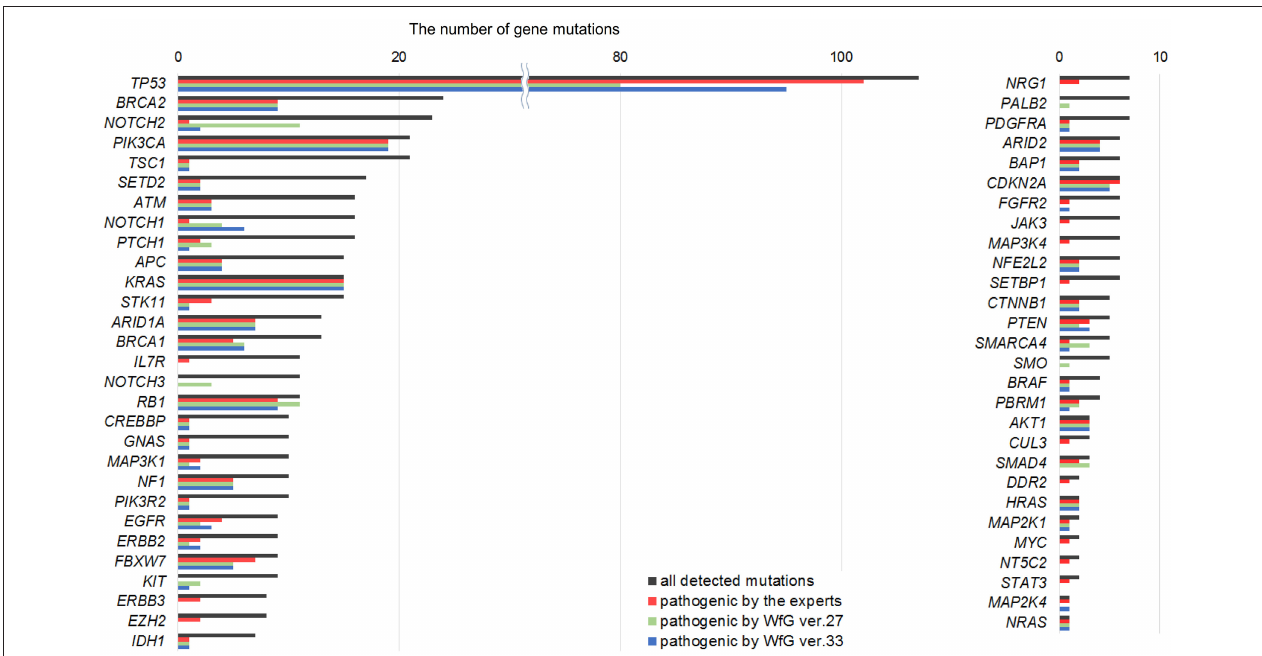
FIGURE 2 | List of all gene mutations and pathogenic mutations detected by the expert panel, WfG ver. 27 and WfG ver.33. The number of all gene mutations detected (excluding SNPs), the number of pathogenic mutations identified by experts, the number of pathogenic mutations identified by WfG ver. 27, and the number of pathogenic mutations identified by WfG ver. 33 are shown. Genes without detected pathogenic mutations are not shown.